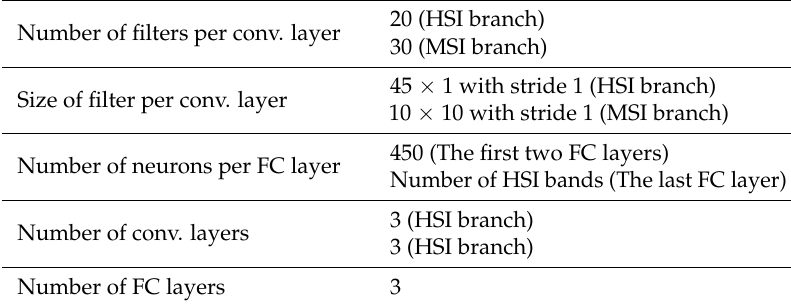
Table 2. The parameter setting of the network